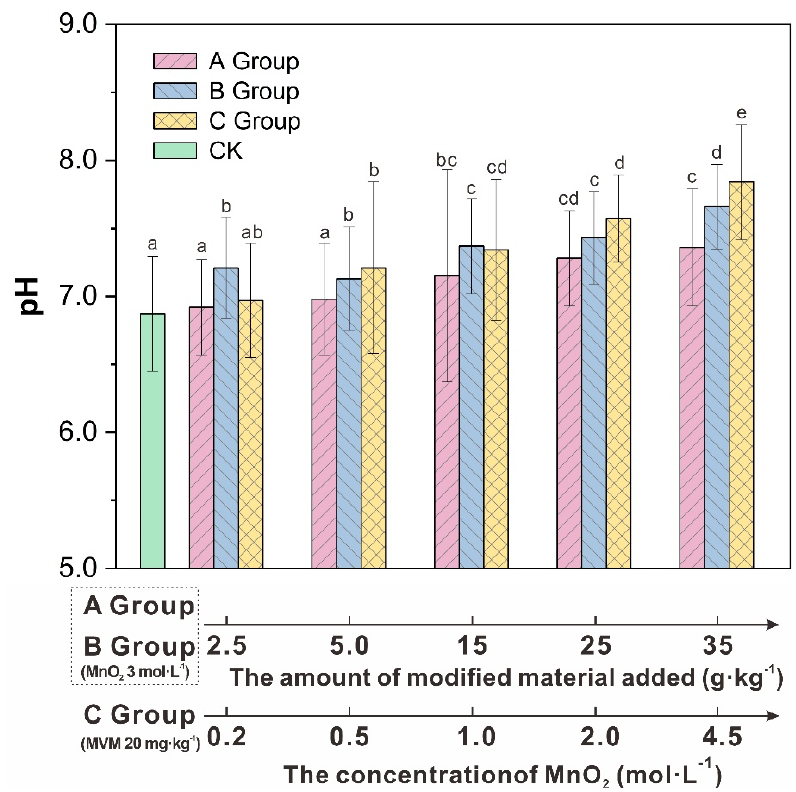
Figure 1. pH values of different groups of soil. (MVM: modified vermiculite-montmorillonite). Different letters above the bar diagram indicate the significant difference of pH in different gruops of soil. The same letters indicate significant differences in means ( p < 0.05).